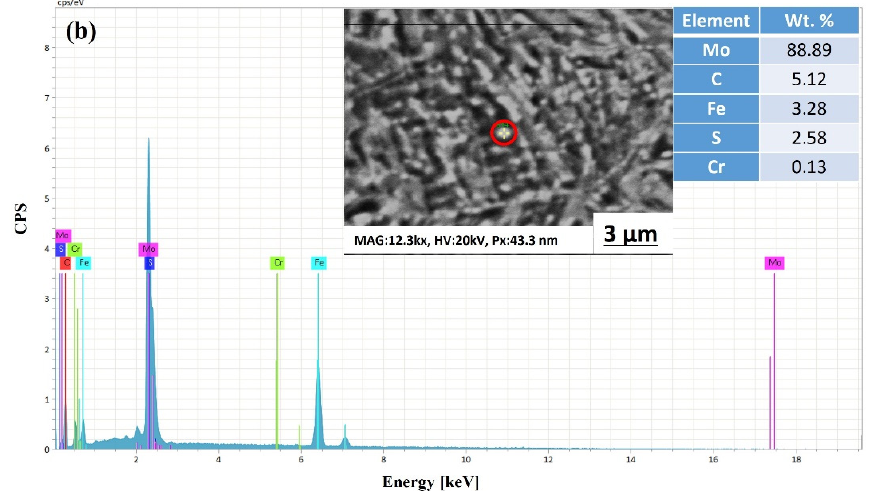
Figure 4. EDS spectra of HT samples at different locations, i.e., ( a , b ). Precipitates were measured using point scanning.